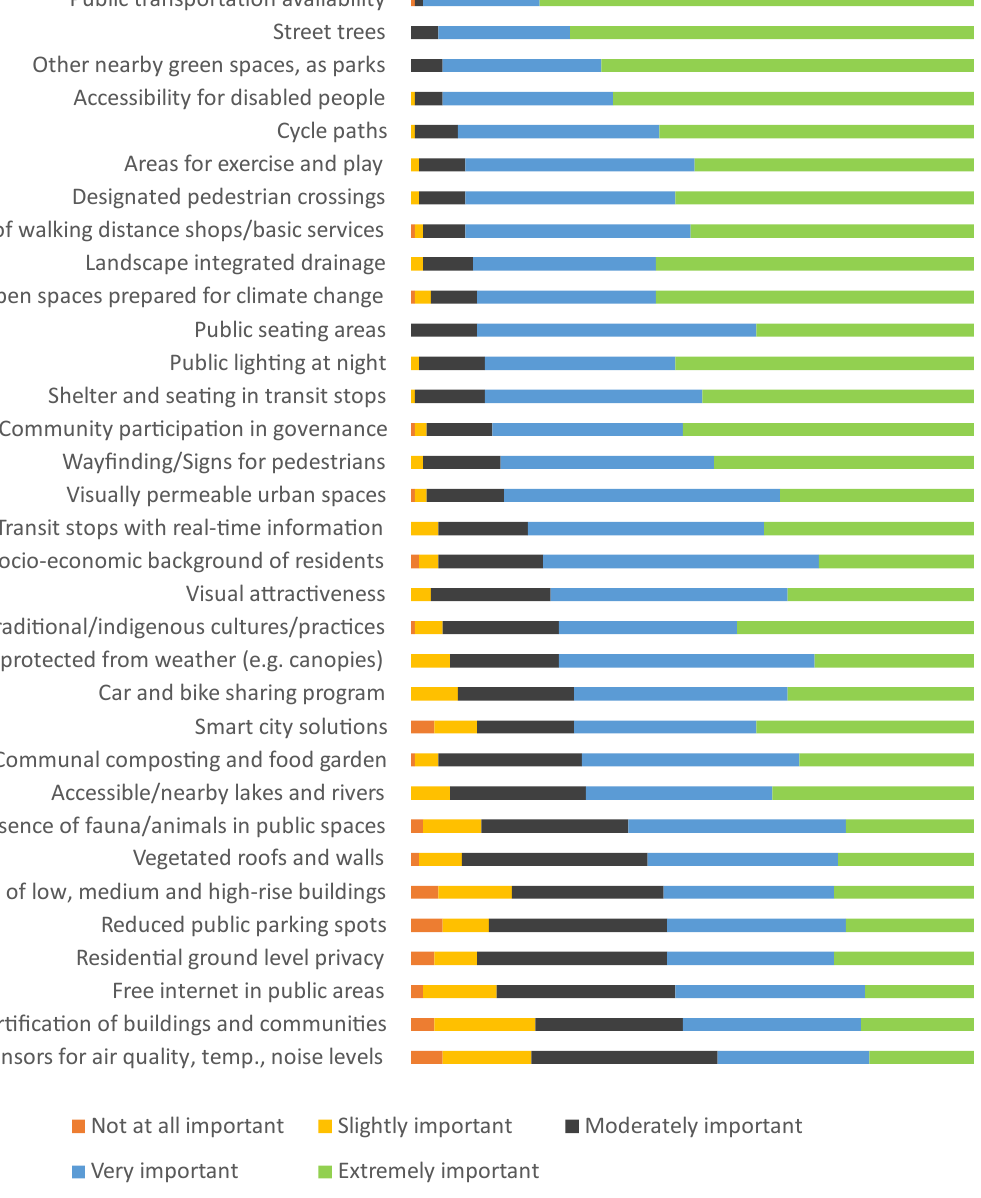
low, medium, and high- rise buildings’, and ‘free internet in public areas’, with 15% or more of respondents considering them not at all important or just slightly important. It